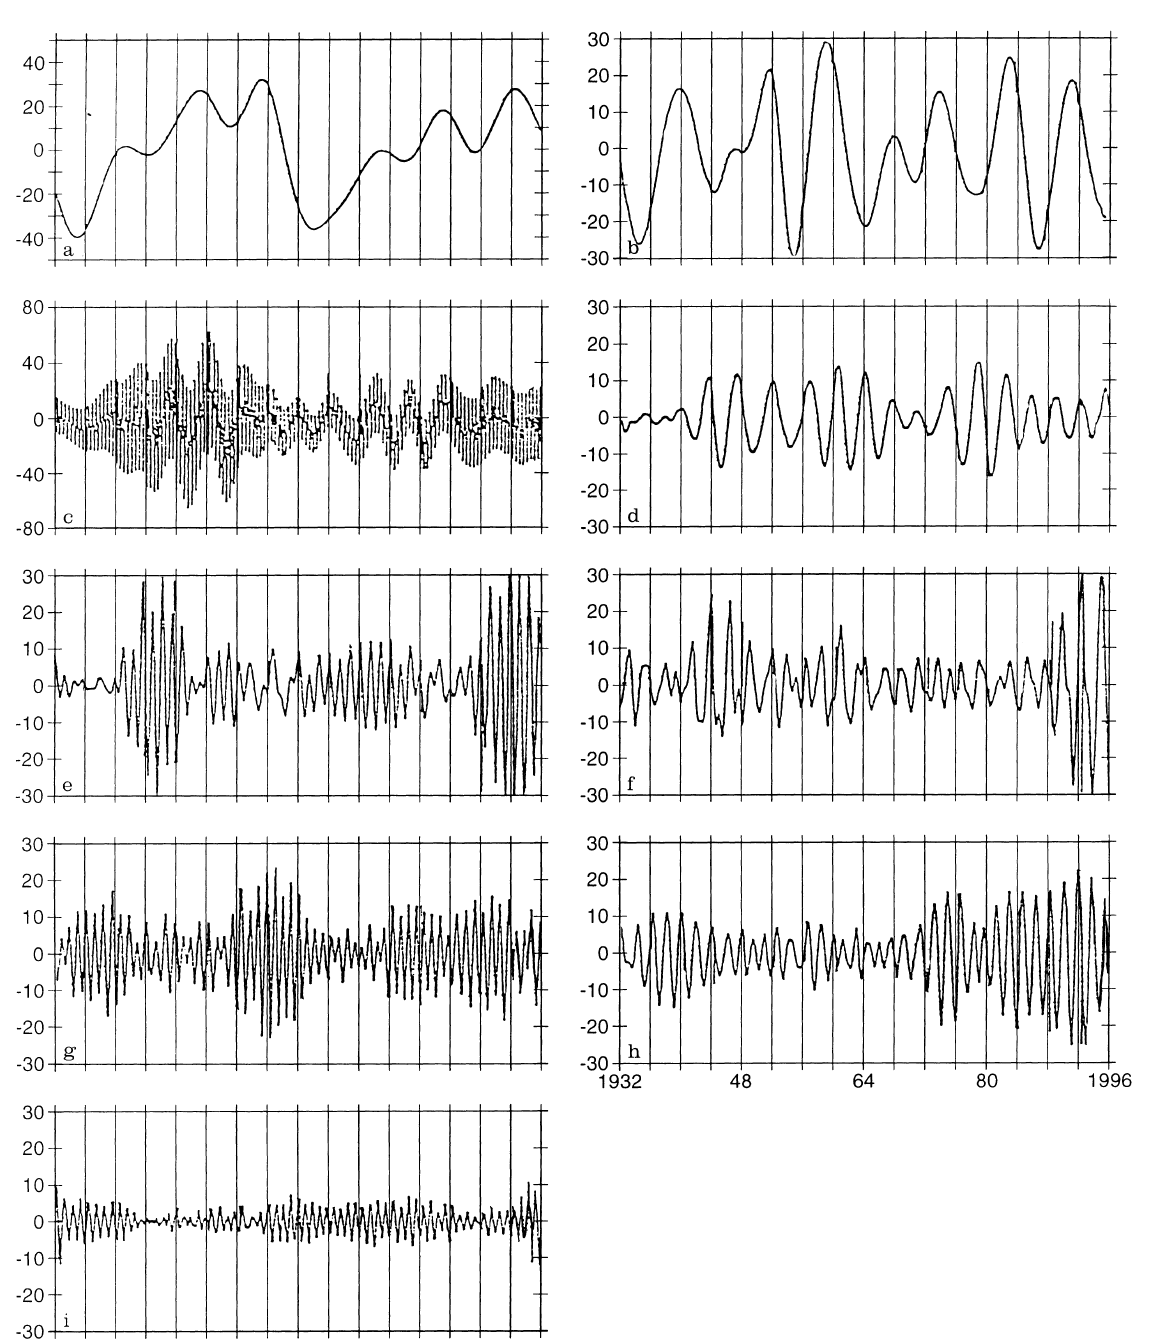
Fig. 8a–i. Reconstructed components of significant oscillations in the time series of monthly mean Ap index, derived from the singular spectrum analysis. Approximate periodicities and the percentage variance accounted by the oscillations